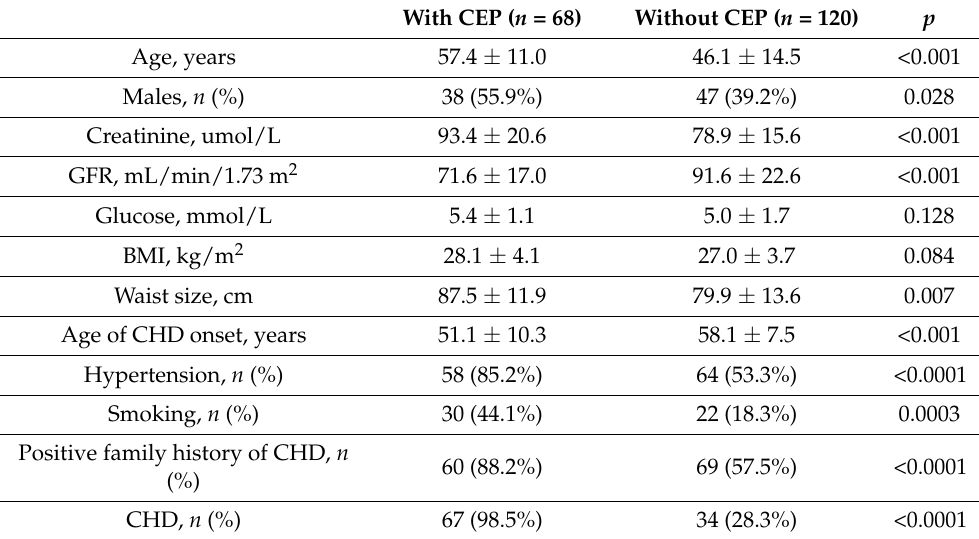
Table 7. Assessment of the global non-lipid risk factors impact for the development of the combined end point (CEP).